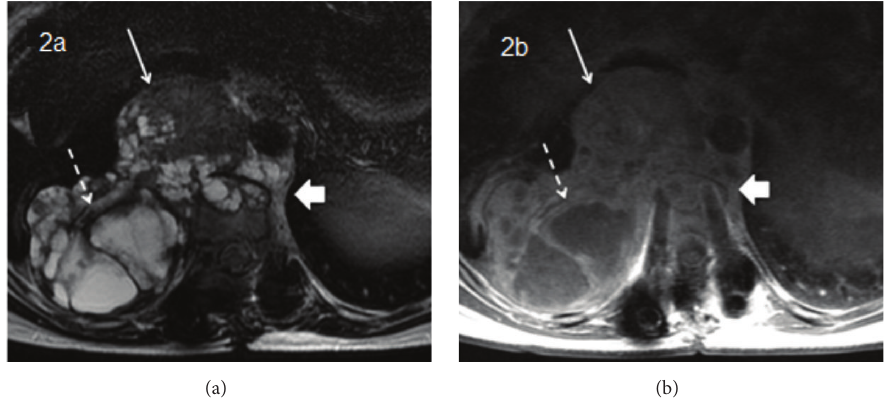
Figure 2: Baseline (pretreatment) MRI findings on T2-weighted (a) and postgadolinium T1-weighted (b) images showing a mass arising from the vertebral body (wide arrow), with a heterogeneous soft tissue component with solid (narrow arrow) and cystic areas (dashed arrow).